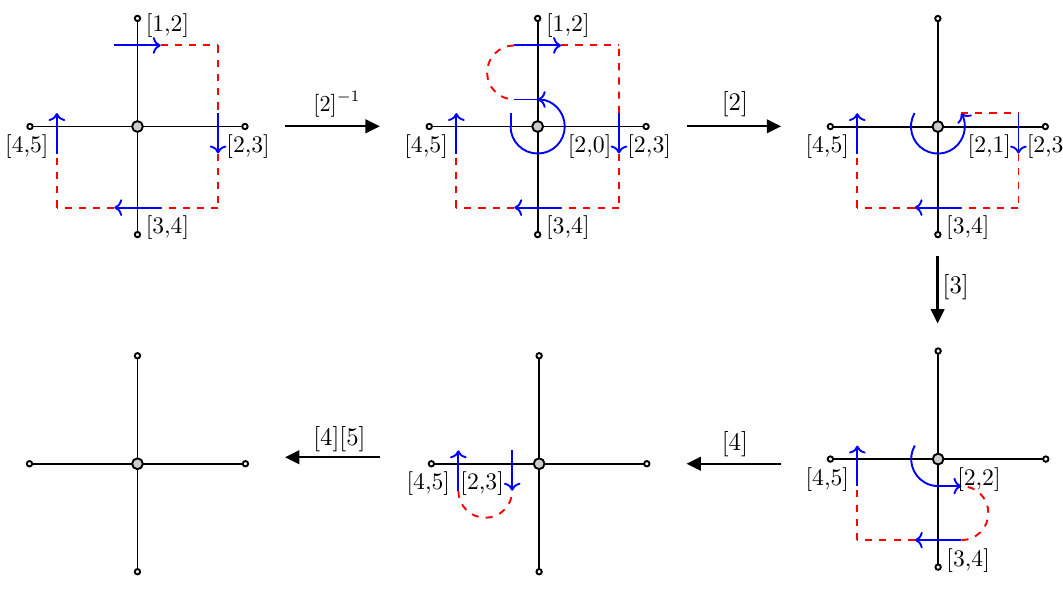
Figure 7 . The sequence of transformations of the monodromy acting onto the cross integral. The Lax operators of the external part of the monodromy act on (cid:12)xed external coordinates. The Lax operator introduced around the integrated middle node acts on the coordinate of this node. Numerical factors appearing in the process are indicated above